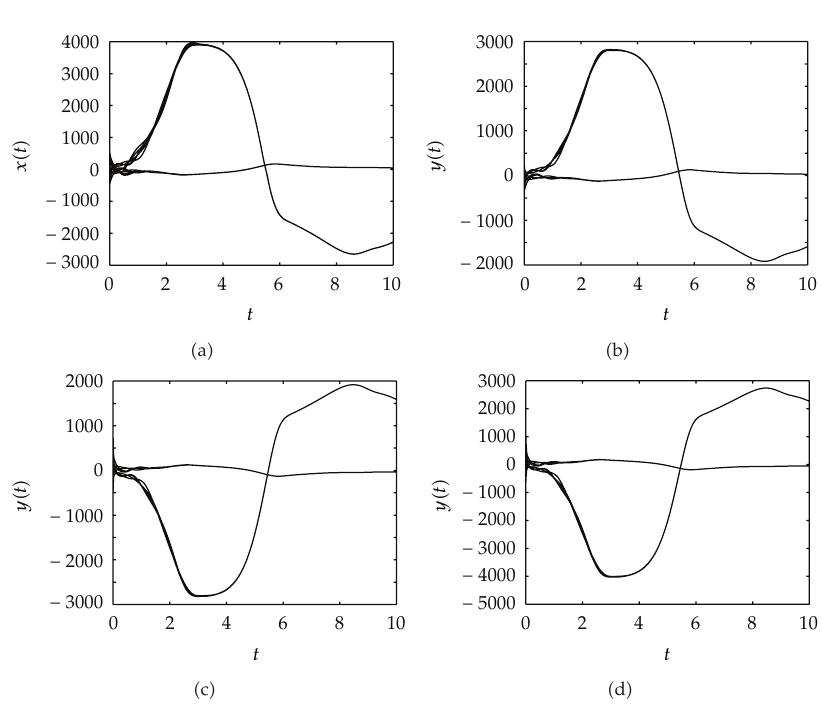
Figure 1: (cid:2) a (cid:3) Trajectory of the drive system. (cid:2) b (cid:3) trajectory of the response system with α (cid:7) 0 . 7. (cid:2) c (cid:3) trajectory of the response system with α (cid:7) − 0 . 7. (cid:2) d (cid:3) Trajectory of the response system with α (cid:7) −